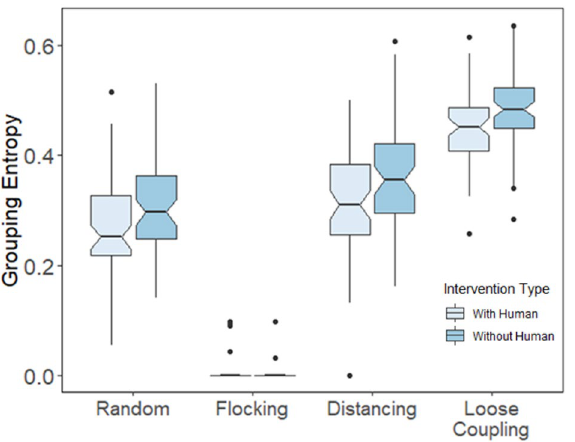
Figure 7. Entropy values for simulated agents as a function of movement type (Random, Flocking, Distancing, and Loose coupling) in the experiment (with human) versus the simulation (without human).